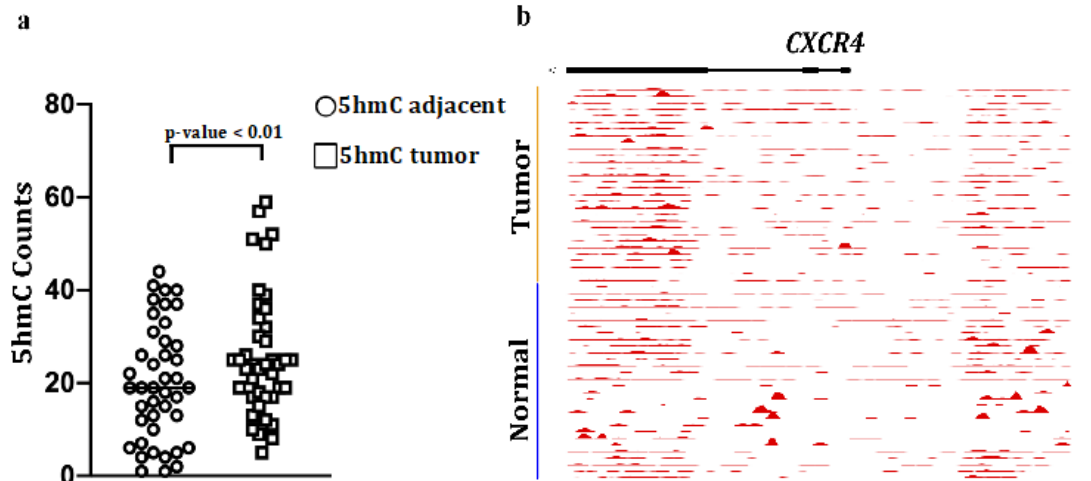
Figure 6. 5-hydroxymethylcytosine (5hmC) abundance in CXCR4 gene bodies in colon cancers and matched adjacent mucosa ( n = 42 samples, p < 0.01, paired Student’s t -test): ( a ) Counts per million reads at CXCR4 gene, ( b ) plus promoter (upstream 3kb region) in matched tumors and adjacent healthy tissue in 30 colorectal cancer patients. The moving averages at 0.01 smoother span are shown. black bars mark